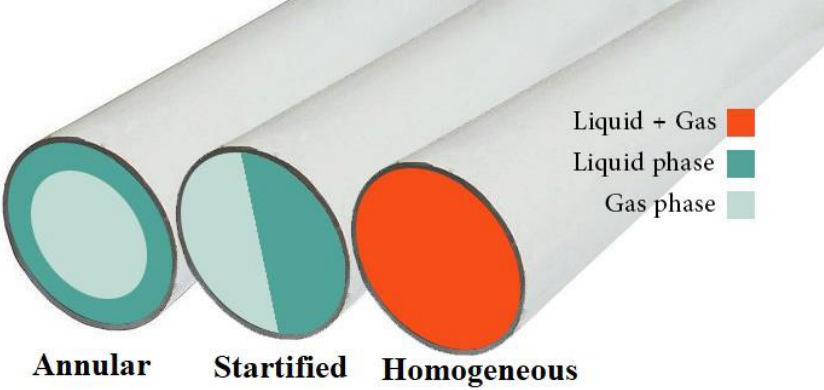
Figure 3. Simulated flow regimes.